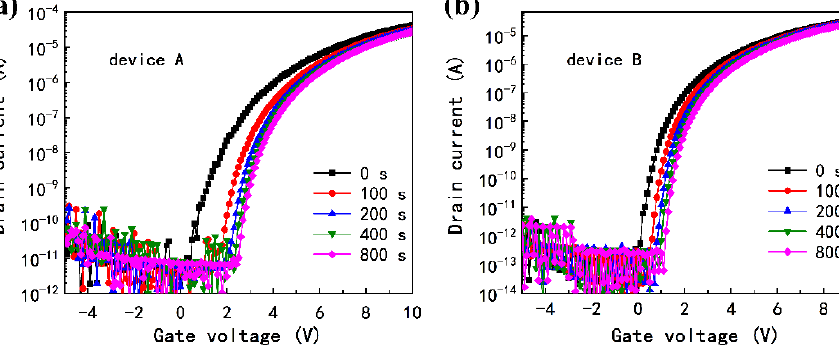
Table 1. Electrical properties of device A, B and compare with other TFTs.